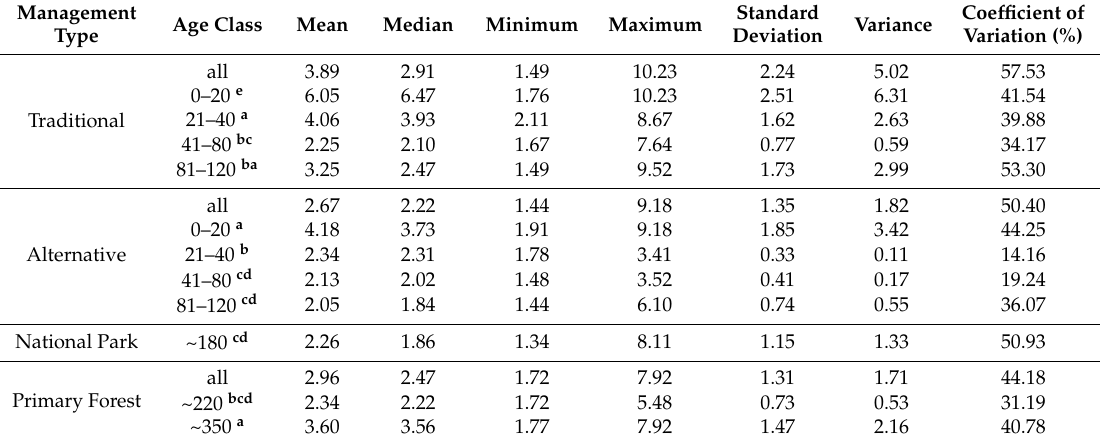
Table 3. Descriptive statistics of understory complexity index (UCI) for each management type and age class. Different letters indicate significant differences between the age classes at p <